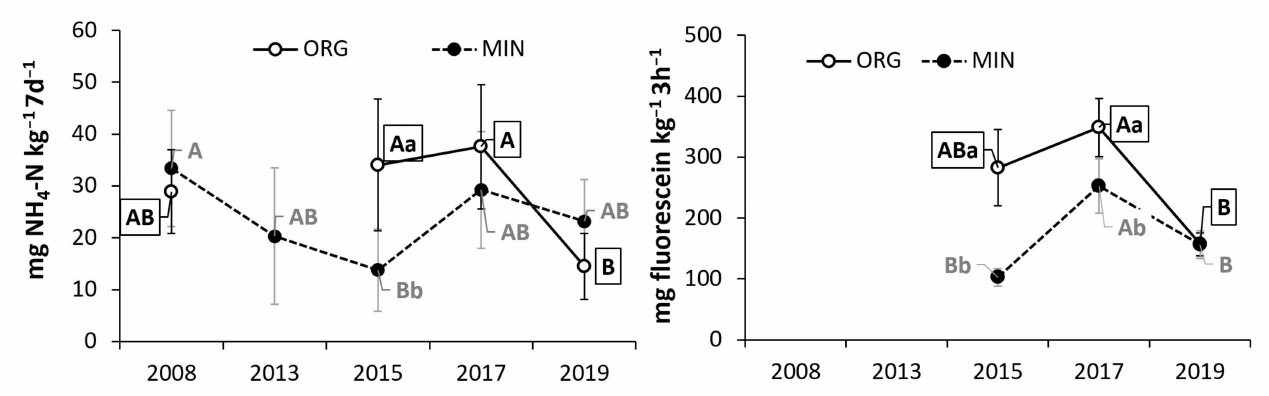
Figure 3. PMN (as mg N-NH 4 kg − 1 7d − 1 ) and FDA hydrolysis (as mg fluorescein kg − 1 3h − 1 ) under ORG and MIN for the different years. Bars indicate the standard deviation of the data. Uppercase letters indicate that means are significantly different among years and lowercase letters indicate that means are different between management practices ( p <